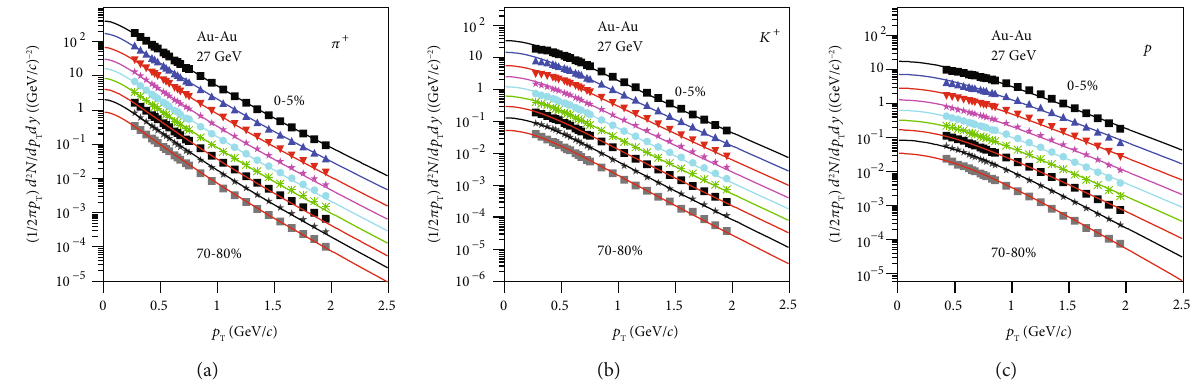
ffiffiffiffiffiffiffiffiffi p = 27 GeV . s NN